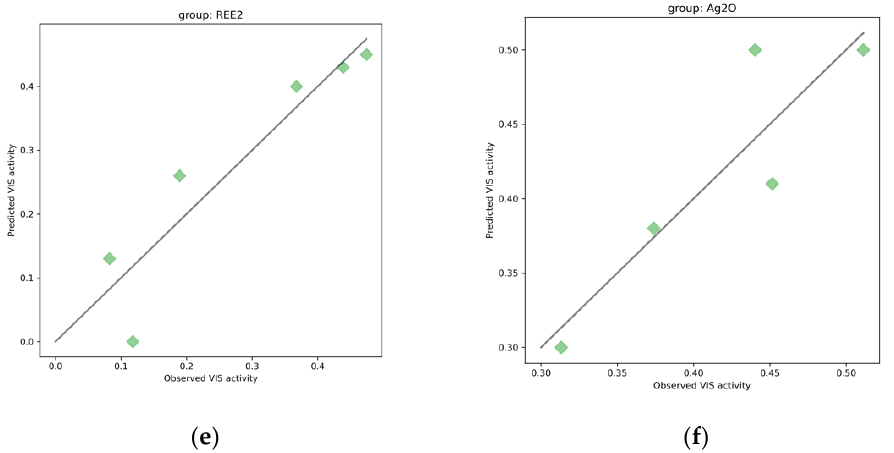
Figure 5. The MLR models for self-organized TiO 2 active under UV-VIS for: ( a ) well-ordered nanotubes in the presence of different types of ionic liquids (TiO 2 /ILs), ( b ) rare-earth metals-modified TiO 2 NTs (TiO 2 /REE), and ( c ) interlaced with silver nanoparticles (TiO 2 /Ag 2 O); active under VIS light ( d ) well-ordered nanotubes in the presence of different types of ionic liquids (TiO 2 /ILs), ( e ) rare-earth metals-modified TiO 2 NTs (TiO 2 /REE), ( f ) interlaced with silver nanoparticles (TiO 2 /Ag 2 O). Particular models ’ equations and statistics are shown in Table S3.